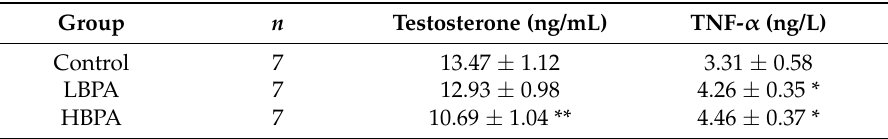
Table 2. Effects of perinatal BPA exposure on serum testosterone and tumor necrosis factor (TNF)- α levels in male offspring. Pregnant mice ( n = 7/group) were exposed to ethanol or BPA in water at levels of 0.2 µ g/mL or 2 µ g/mL from gestational day 6 through to the end of lactation. Values represent the means ± SE ( n = 7, one from each group).